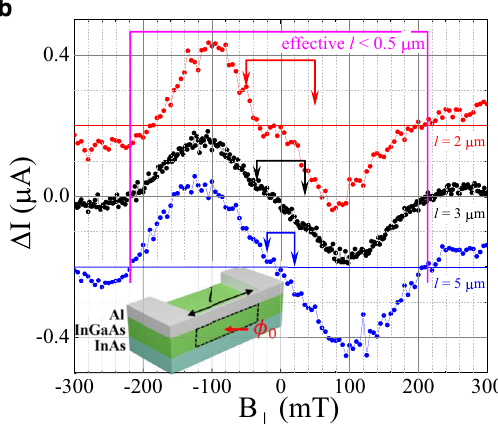
Fig. 2 | Dependence of NRC on the nanowire length and crystallographic orientation.a NRCisplottedfortwo2 μ m-longwiresorientedalong[110]and ½ 110 (cid:3) crystallographic axes. Insets de fi ne mutual orientataion of wires and fi elds. b NRC for2,3,and5 μ mwires.Thetopandbottomcurvesareshiftedverticallyby0.2 μ A.